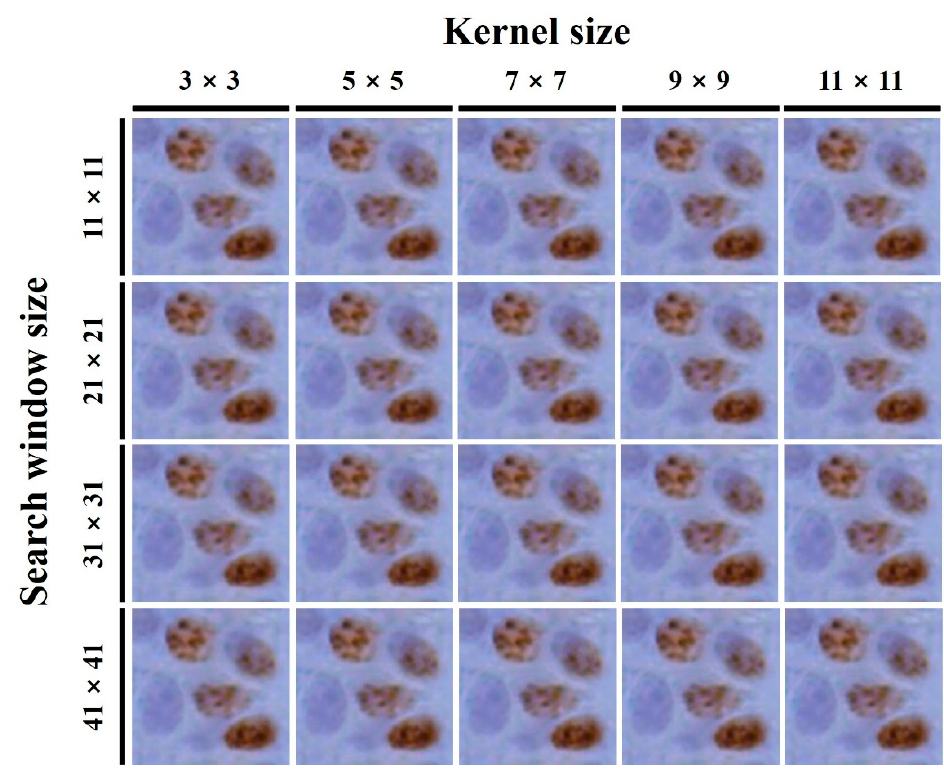
Figure 4. Color LM images filtered using the FNLM algorithm with various kernel and search window sizes.